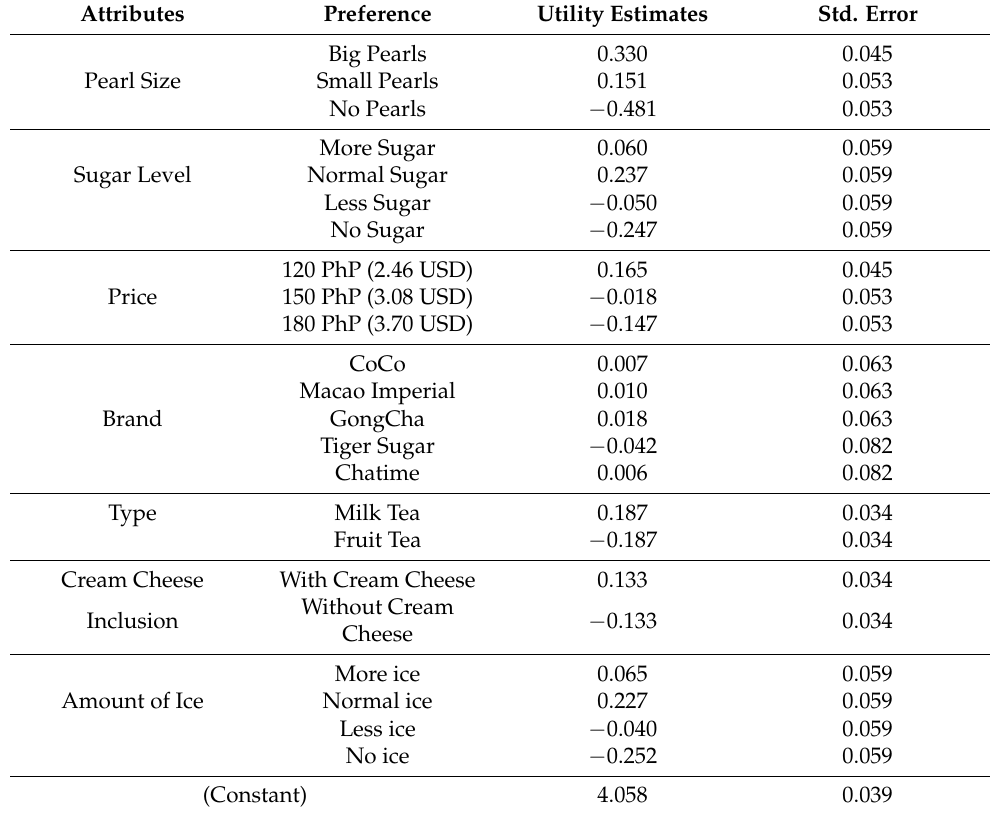
Table 4. Utilities.